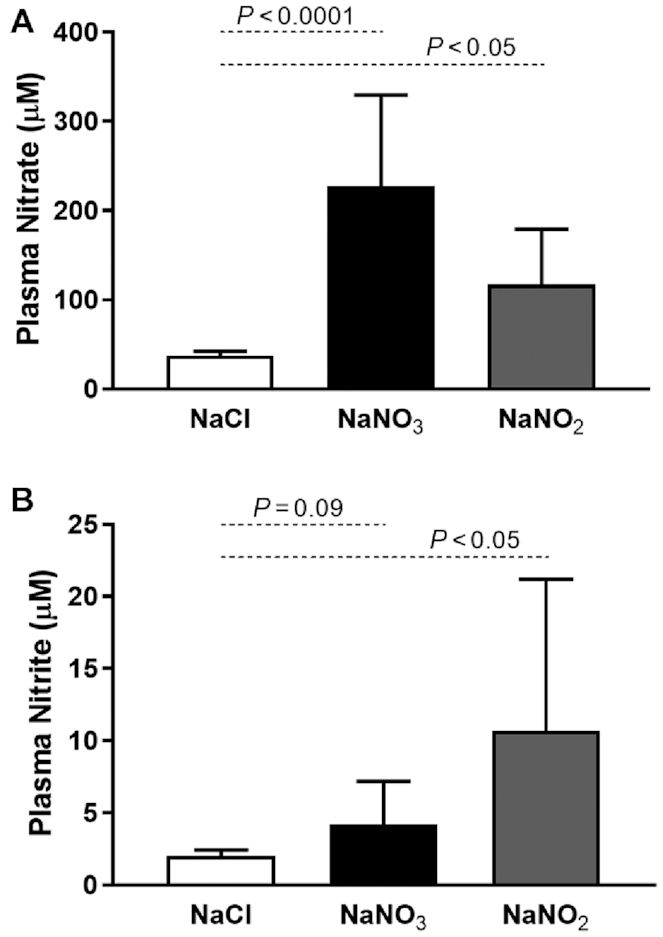
Plasma \documentclass[12pt]{minimal}
\usepackage{amsmath}
\usepackage{wasysym}
\usepackage{amsfonts}
\usepackage{amssymb}
\usepackage{amsbsy}
\usepackage{upgreek}
\usepackage{mathrsfs}
\setlength{\oddsidemargin}{-69pt}
\begin{document}
}{}${\rm{NO}}_3^ - $\end{document} and \documentclass[12pt]{minimal}
\usepackage{amsmath}
\usepackage{wasysym}
\usepackage{amsfonts}
\usepackage{amssymb}
\usepackage{amsbsy}
\usepackage{upgreek}
\usepackage{mathrsfs}
\setlength{\oddsidemargin}{-69pt}
\begin{document}
}{}${\rm{NO}}_2^ - $\end{document} concentrations in mice after supplementation with sodium nitrate (n = 10–13 per group) or sodium nitrite (n = 6 per group) for 7 d. (A) Plasma \documentclass[12pt]{minimal}
\usepackage{amsmath}
\usepackage{wasysym}
\usepackage{amsfonts}
\usepackage{amssymb}
\usepackage{amsbsy}
\usepackage{upgreek}
\usepackage{mathrsfs}
\setlength{\oddsidemargin}{-69pt}
\begin{document}
}{}${\rm{NO}}_3^ - $\end{document} concentrations in mice supplemented with sodium nitrate or sodium nitrite. (B) Plasma \documentclass[12pt]{minimal}
\usepackage{amsmath}
\usepackage{wasysym}
\usepackage{amsfonts}
\usepackage{amssymb}
\usepackage{amsbsy}
\usepackage{upgreek}
\usepackage{mathrsfs}
\setlength{\oddsidemargin}{-69pt}
\begin{document}
}{}${\rm{NO}}_2^ - $\end{document} concentrations in mice supplemented with sodium nitrate or sodium nitrite.